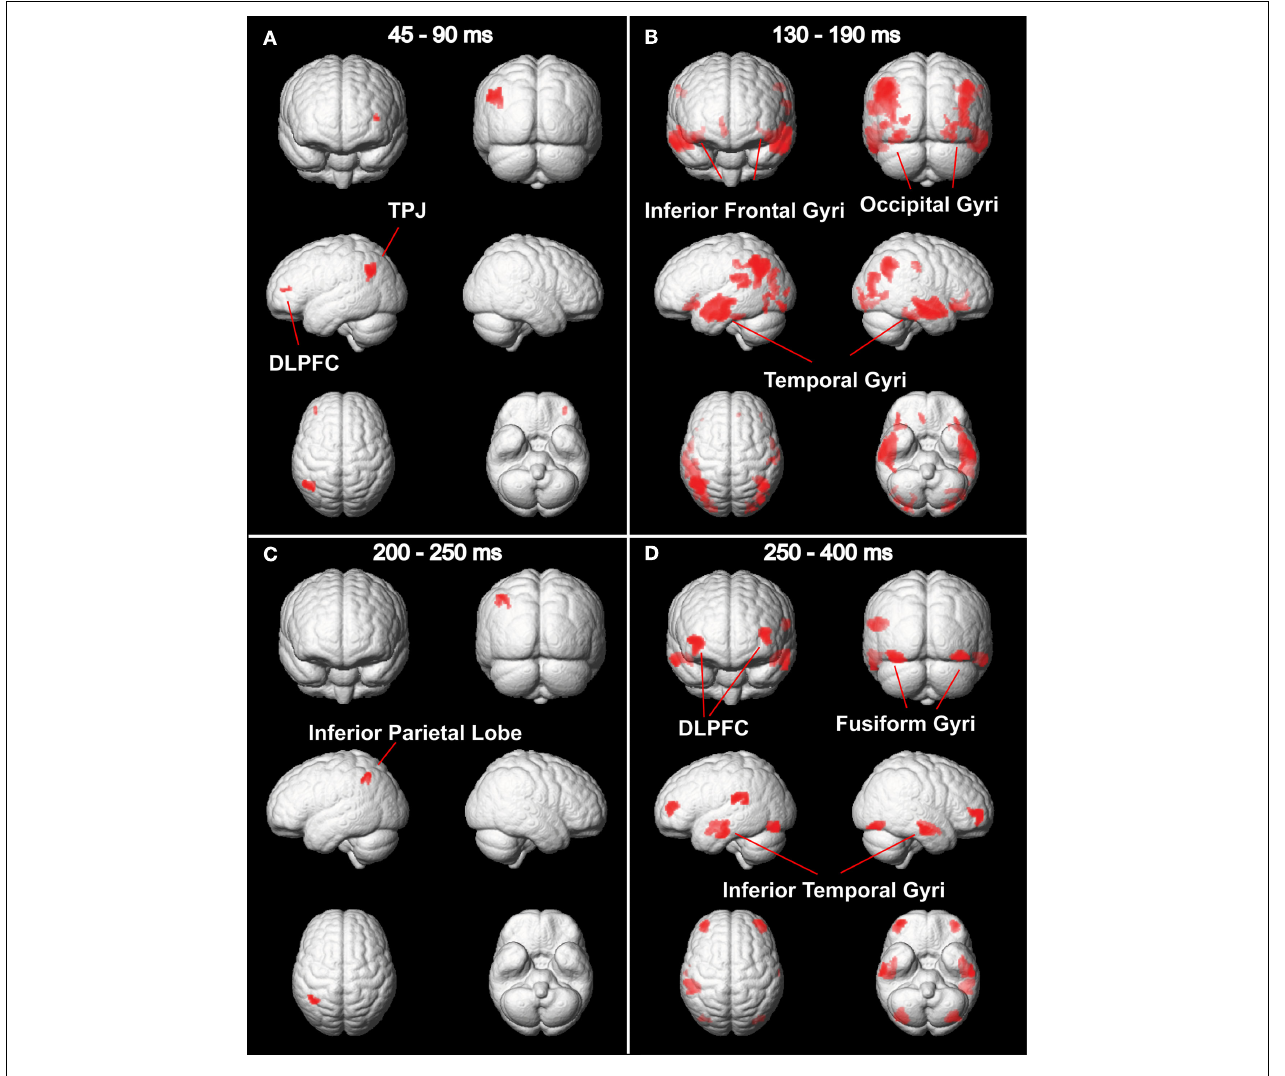
and temporal gyri; (C) between 200 and 250ms, corresponding to the latency of the N2, in the inferior parietal lobe and finally (D) between 250 and 400ms, corresponding to the latency of the P3, in the DLPFC, fusiform, and inferior temporal gyri. See Table 1 for MNI coordinates and number of